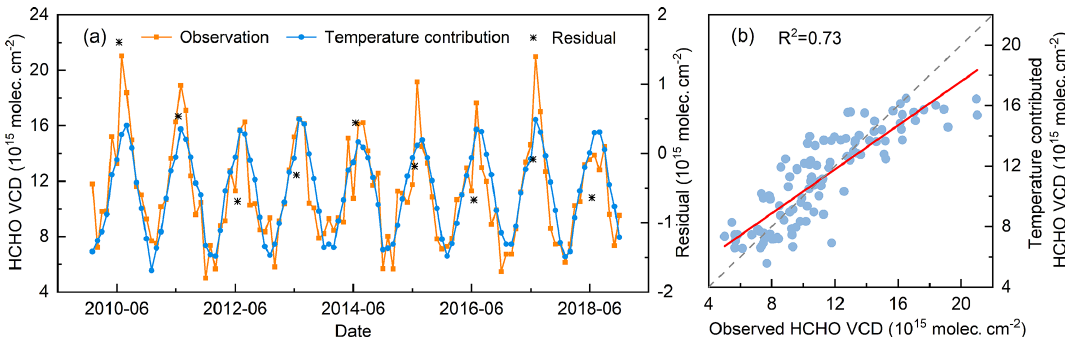
Figure 3. Monthly HCHO VCDs and the temperature contribution in Shanghai during 2010–2018. Panel (a) reflects the temporal variations, and (b) illustrates the correlation analysis. The black points represent the annual average residuals.